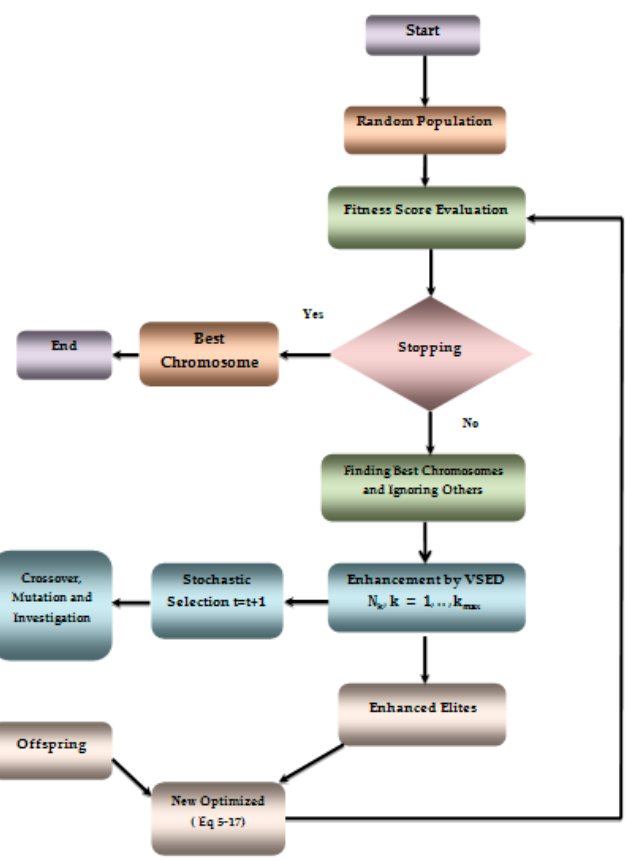
Figure 1. Diagram of the hybrid genetic algorithm (HGA) Algorithm.